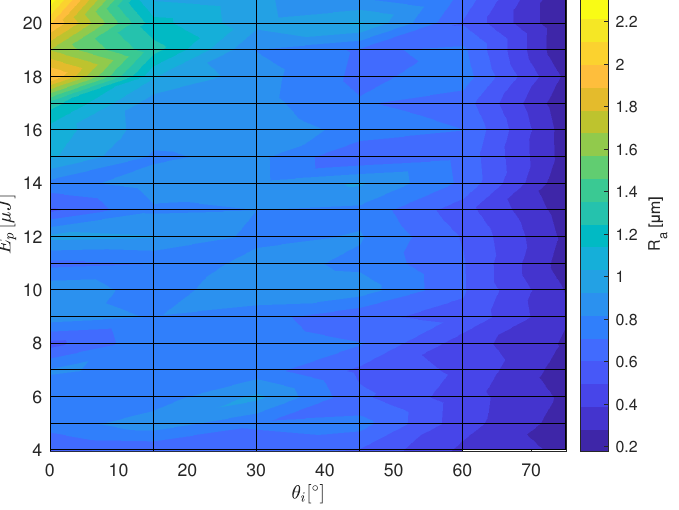
Figure 8. Ra values measured on the SiAlON ceramic LKT 550 for the range of pulse energies and the tilt angles from the calibration experiment (see Figure